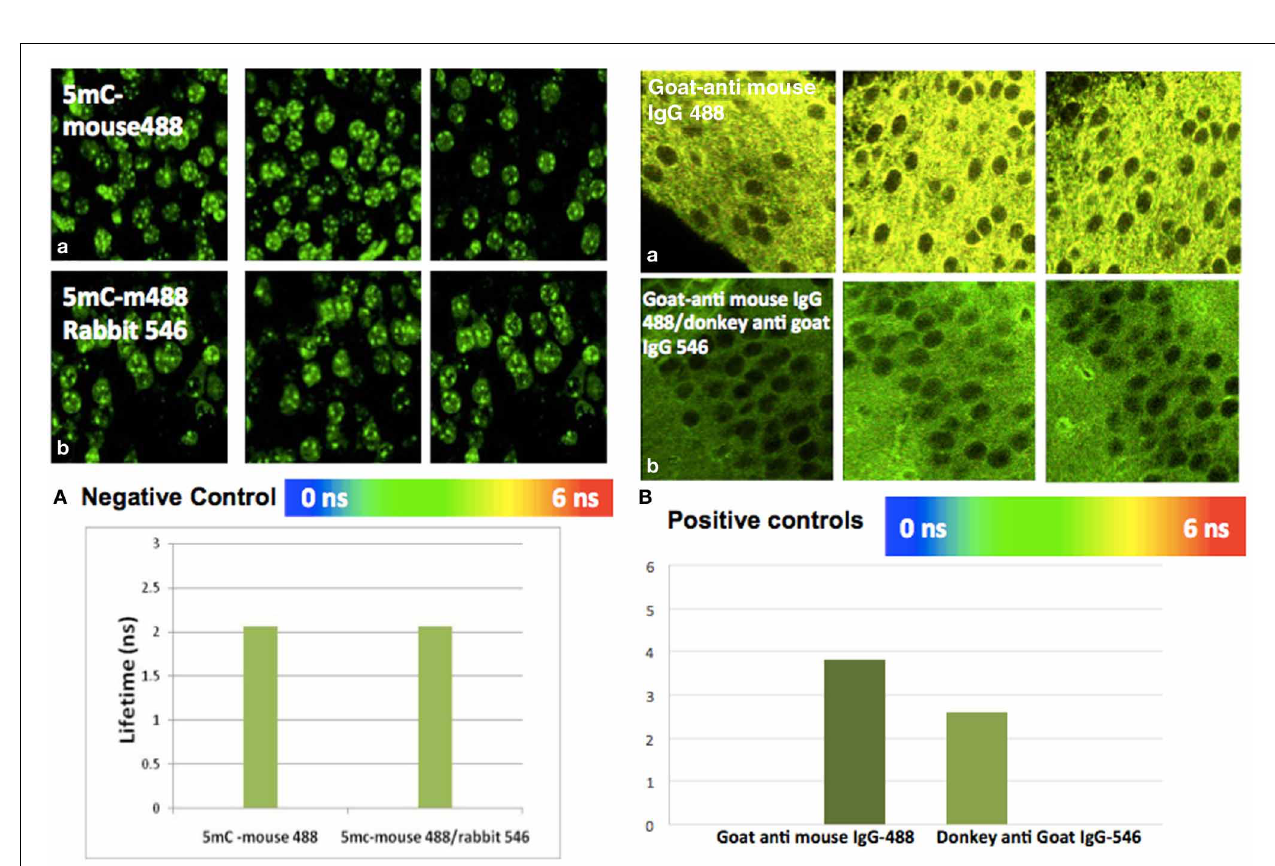
FIGURE A2 | Positive and negative control study by FLIM-FRET. (A) Negative control: There is no interaction between mouse IgG Alexa488 and anti Rabbit IgG Alexa546. (a) Average lifetime anti-5mC mouse IgG Alexa488 was 2.128ns. (b) Average lifetime of anti-5mC mouse IgG Alexa488 and mouse anti rabbit-ant IgG Alexa546 was 2.120ns. There is no significant change (FRET efficiency > 0.05 and at P > 0 . 05) between mean lifetime of donor and acceptor in